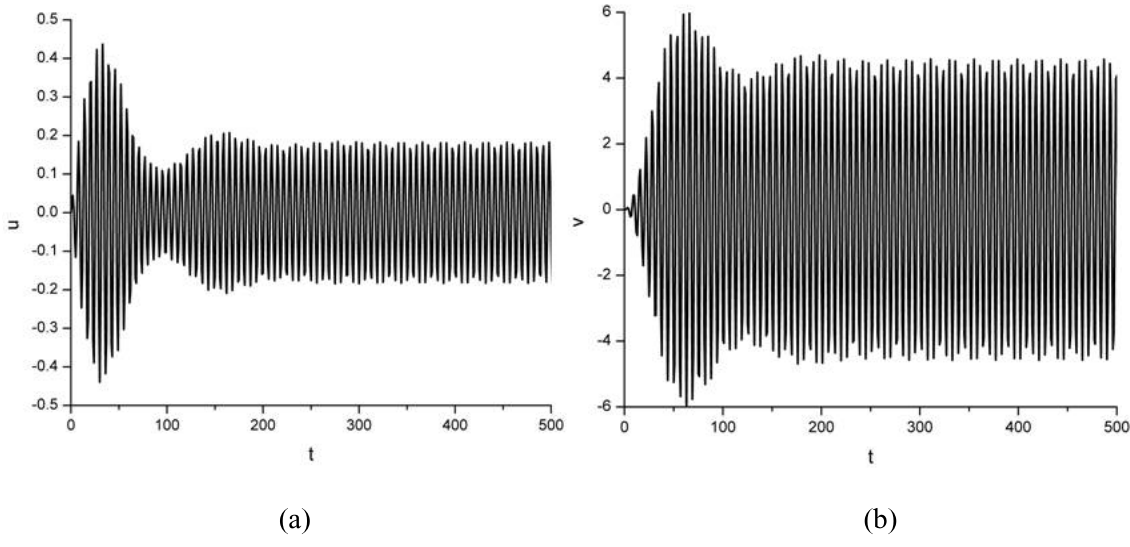
Fig. 17. Numerical simulation of the time response of (a) the plant and (b) the absorber when ω 2 = 1 . 0 , Ω = 1 . 0 and G = 0 . 01